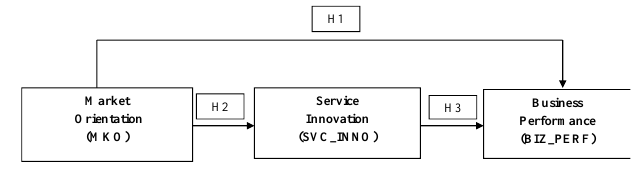
Figure 1: Conceptual framework Sample and